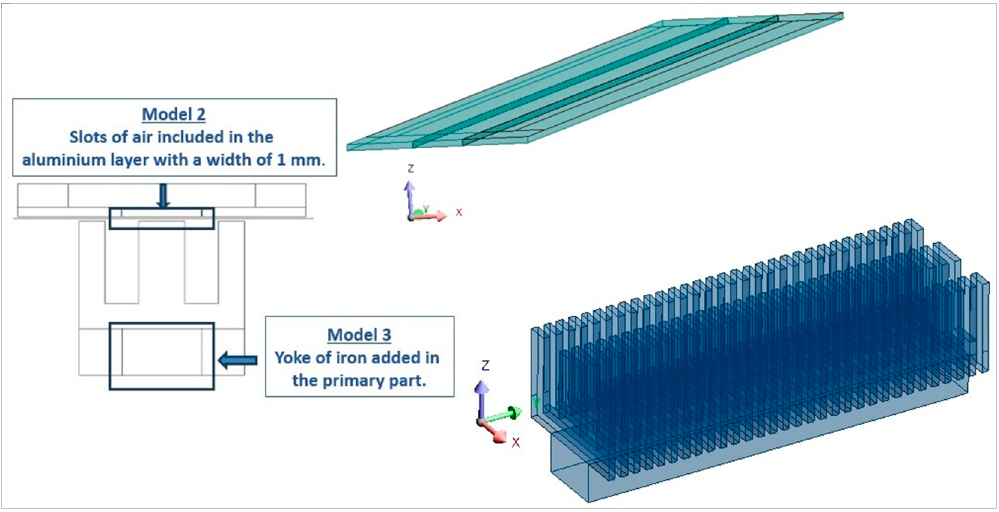
Appl. Sci. 2020 , 10 , x FOR PEER REVIEW Figure 6. Changes included in models 2 and 3. Figure 6. Changes included in models 2 and 3.